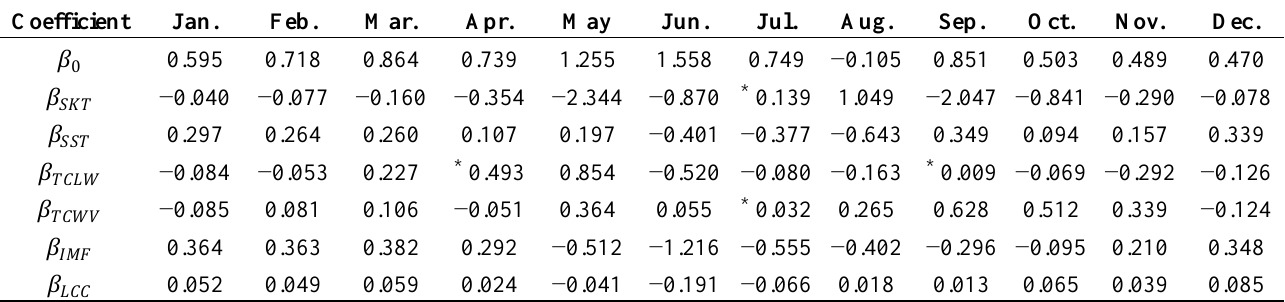
Table 1. Coefficients of the OLS regression models calibrated during 1979–2011. denotes intercept, and 𝛽 𝛽 0 skin temperature, sea surface temperature, total column liquid water, total column water vapor, instantaneous moisture flux, and low cloud cover,